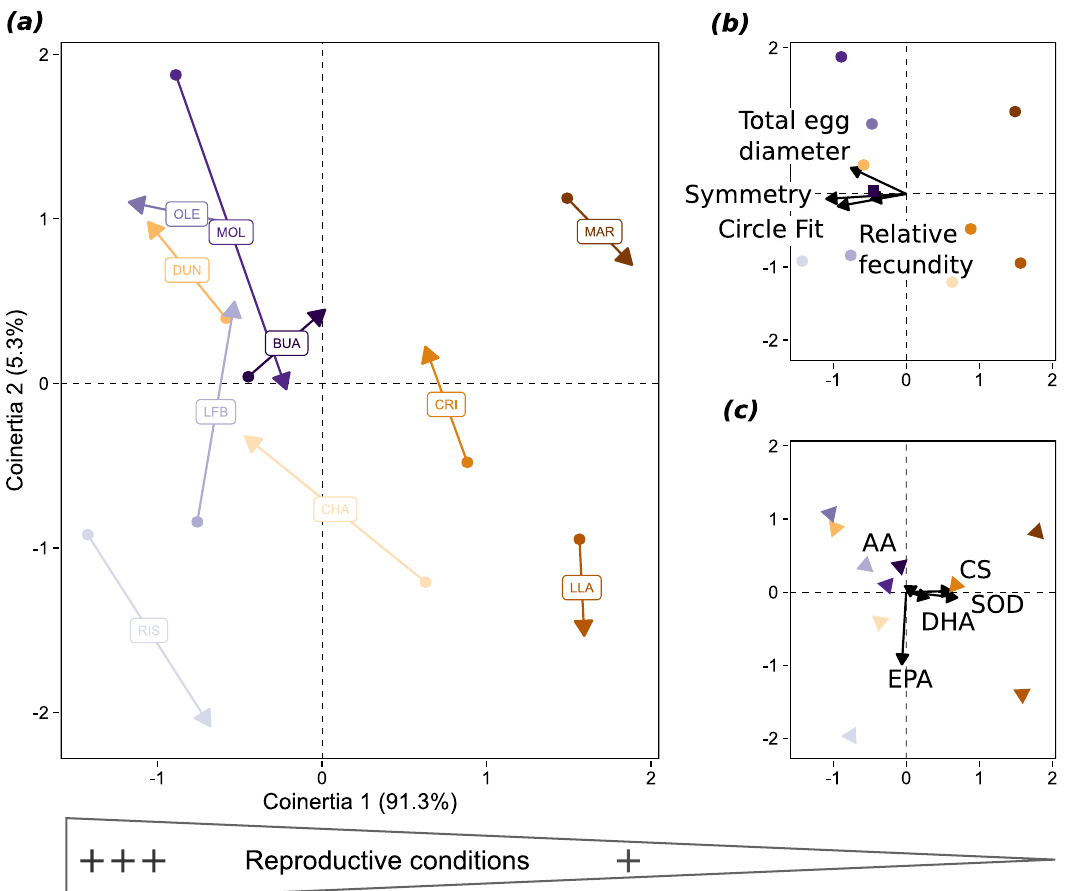
Figure 2. Graphical results of the co-inertia analysis of the reproductive and biochemical variables for winter 2018. The left-hand plot ( a ) (normed site-scores) shows the position of the sites on the co-inertia axes using the reproductive (origins of the arrows) and biochemical (arrowheads) co-inertia weights. The shorter the arrows, the better the match between the two projections. The right-hand pair of plots shows the contribution of the two groups of variables to the canonical space (reproductive traits ( b ) on the top; biochemical variables on the bottom ( c )). Vectors pointing in the same direction are correlated and longer vectors contribute more to the structure. Site name abbreviations are as follows: Maryport MAR, Llanddulas LLA, Criccieth CRI, Champeaux CHA, Douarnenez, plage du Ris RIS, La Fontaine aux Bretons LFB, Oléron OLE, Moledo MOL, Buarcos BUA. Biochemical abbreviations as in Fig.